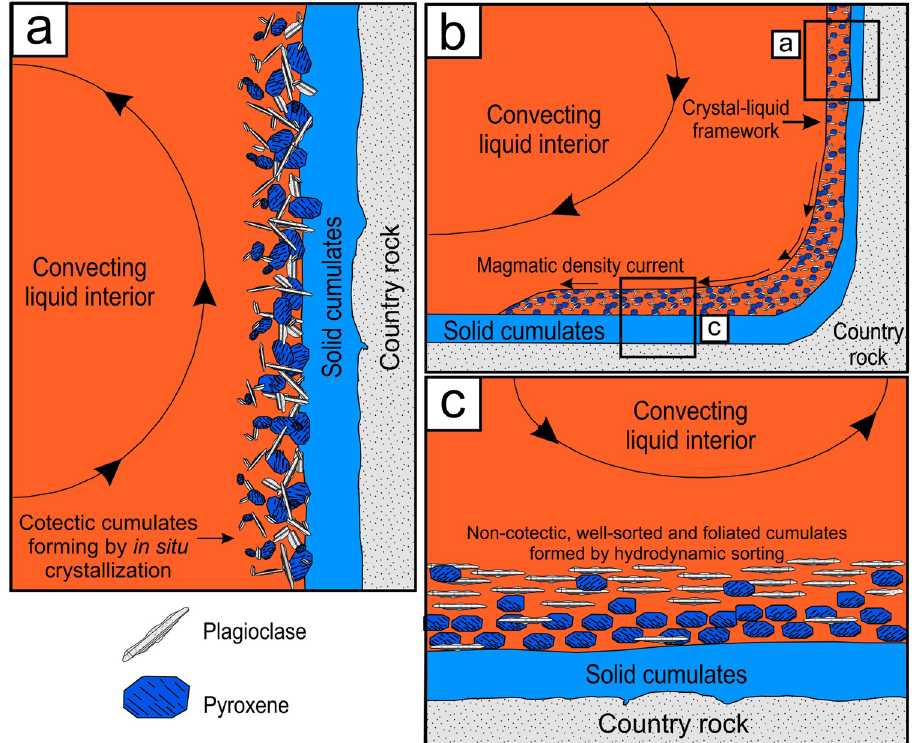
Fig. 1 A magma chamber model for the common case where a basaltic melt crystallizes plagioclase and pyroxene to illustrate the differences that may arise in primocrysts that accumulate by in situ growth versus those that are transported. a Diagram shows the wall of a magma chamber where heat loss through the country rock results in the nucleation and growth of crystals at the chamber margin and eventually on each other (in situ crystallization). With time, this results in a rock that has a large assortment of grain sizes with random orientations in more or less cotectic mineral proportions. b In some instances, the crystals on the chamber wall may become unstable, causing them to collapse and fl ow downwards as a density current to and along the chamber fl oor 27 . c This fl ow of the crystal mush may cause grains to become sorted by size and density, leading to rocks with non-cotectic proportions of minerals that may also display a well-developed foliation. While this example illustrates crystal transport by a density current, the same effect can also be achieved by other means, for instance, by gravity settling of crystals from the chamber interior following their homogeneous